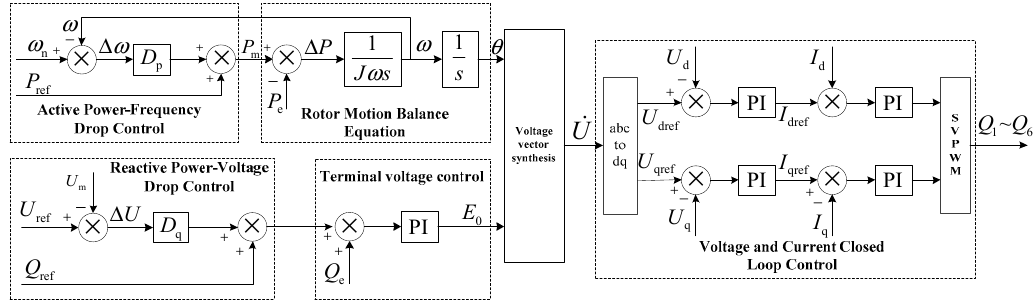
Figure 1. Principle and embodiment of the virtual synchronous generator (VSG).